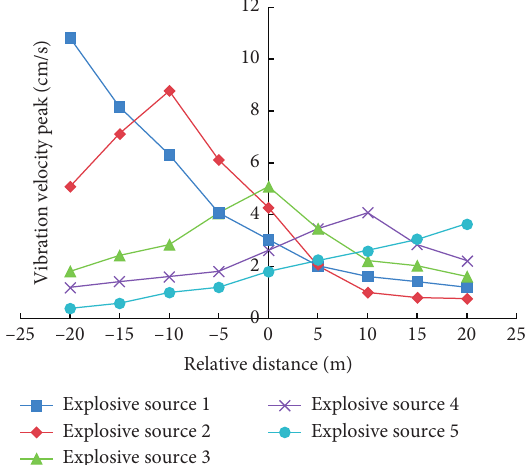
Figure 9: Variation curves of vibration velocity peak with relative distance from explosive